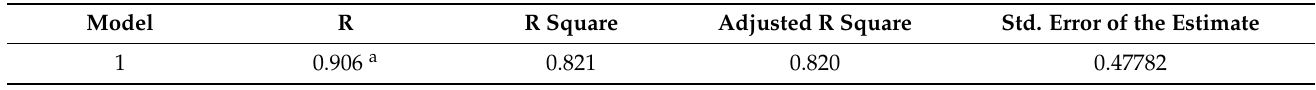
Table 3. Regression Model